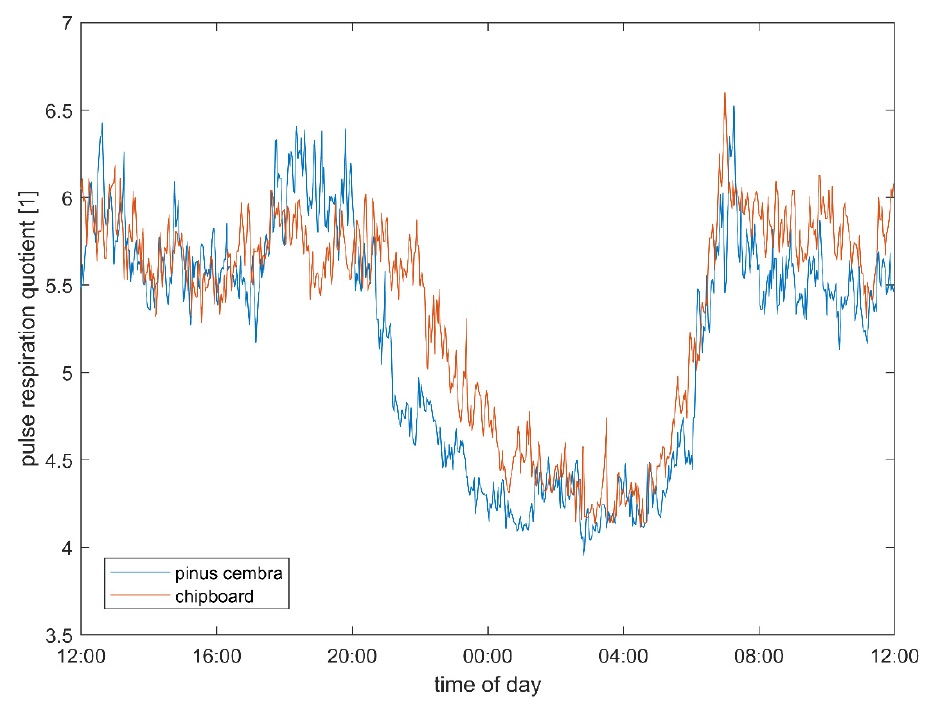
Figure 5. Pulse–respiration quotient (Qpr) as computed from the Holter ECG recordings, when the subjects slept in the solid wood beds (blue) and in the chipboard beds (red). Each curve represents the average of 90 nights of measurements for 15 subjects. The Qpr is higher during the day and approaches a relation of four heartbeats per respiratory cycle during the night. If the subjects slept in the stone pine bed, 4:1 was reached about two hours earlier than if they slept in the control bed. As seen for the heart rate and the vagal activity, the strongest difference in the pulse–respiration quotient was found during the first phase of sleep. The effect of lower Qpr also persists in the morning after the waking.